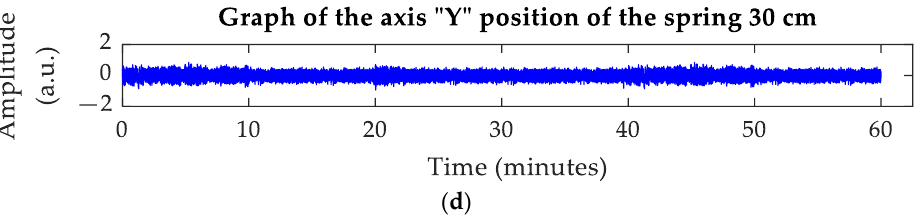
Figure 4. ( a ) ratio between amplitude of the “Y” axis and time in seconds at the spring position 4 cm, a.u. (arbitrary units); ( b ) ratio between amplitude of the “Y” axis and time in seconds at the spring position 10 cm, a.u. (arbitrary units); ( c ) ratio between amplitude of the “Y” axis and time in seconds at the spring position 20 cm, a.u (arbitrary units); ( d ) ratio between amplitude of the “Y” axis and time in seconds at the spring position 30 cm, a.u (arbitrary units).